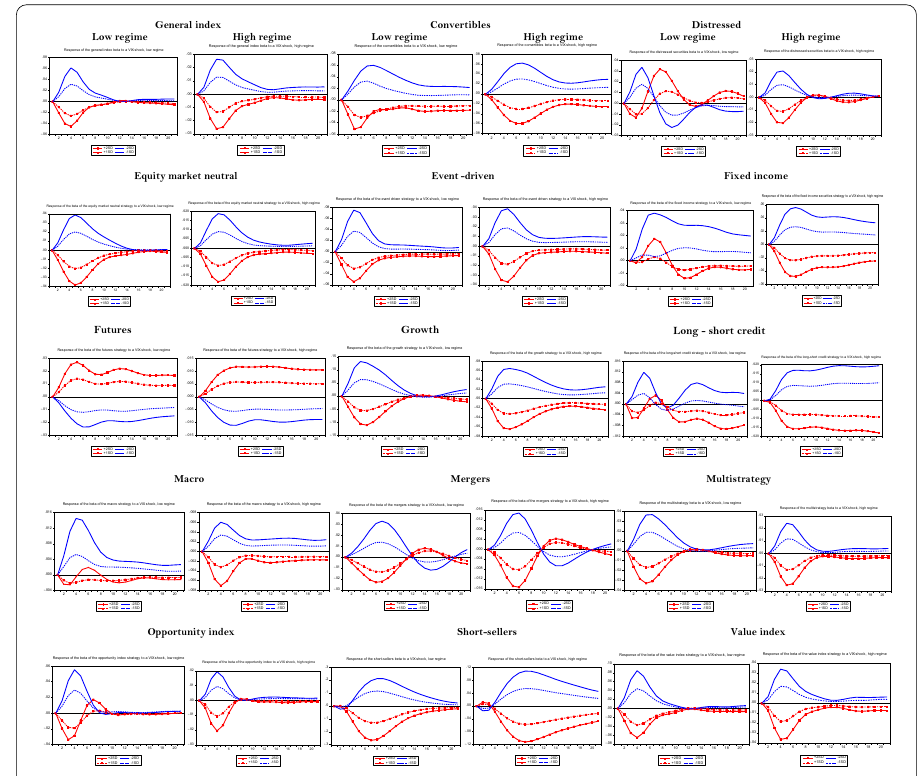
Fig. 11 Response of hedge fund beta to moderate and strong negative and positive VIX shocks in low and high regimes, general index and strategies. Notes: These plots correspond to the impulse response functions of strategies’ betas to VIX shocks. They are built with the Balke’s (2000) nonlinear impulse response functions algorithm using the generalized impulse response function to identify structural shocks (Koop et al. 1996; Pesaran and Shin 1997, 1998). For each strategy, we have two kinds of shocks: positive and negative VIX shocks, and moderate and strong shocks, corresponding to one and two standard deviations of the value of the shocks, respectively, for a total of four impulse response functions by regime for each strategy. Moreover, Balke (2000) considers two categories of regimes separated by an optimal threshold value: a low and a high regime. The significance of the threshold values is evaluated with Wald tests. We use GDP growth to compute the threshold value separating the